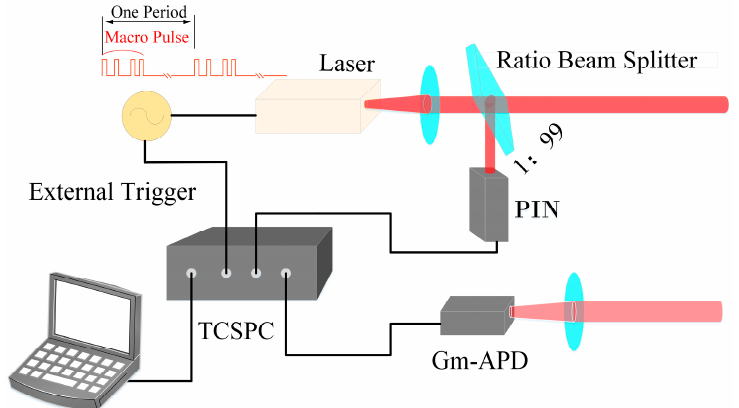
Figure 1. Schematic of the macro-pulse photon counting Lidar system, TCSPC (time-correlated single-photon counting), Gm-APD (Geiger-mode avalanche photodiode).